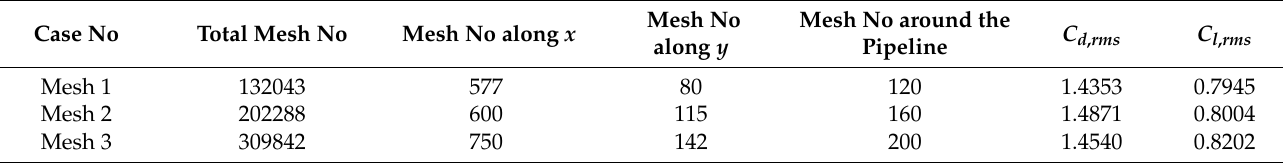
Table 1. Comparisons of hydrodynamic forces on the single pipeline for different mesh